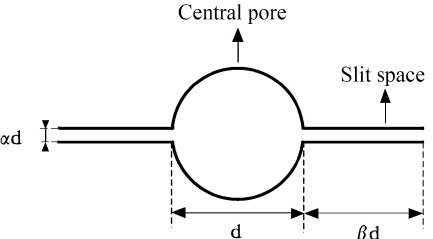
Figure 2. Pore model containing two slit-shaped spaces ( d denotes the diameter of the central pore, and αd and βd denote the widths and lengths of the slit-shaped spaces,